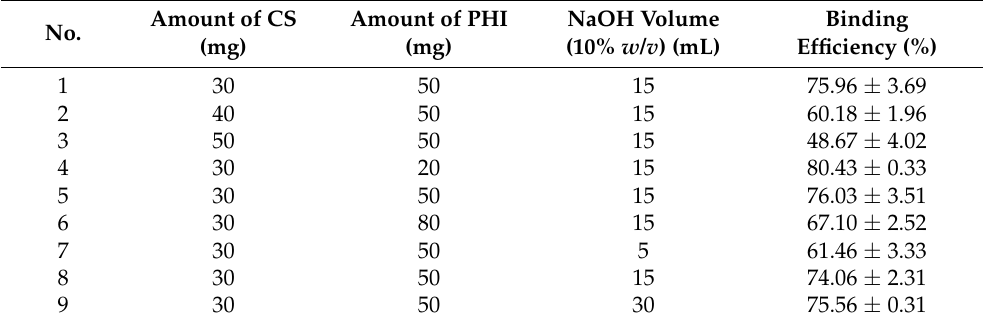
Table 2. Binding efficiency of PHI/CS ( n =